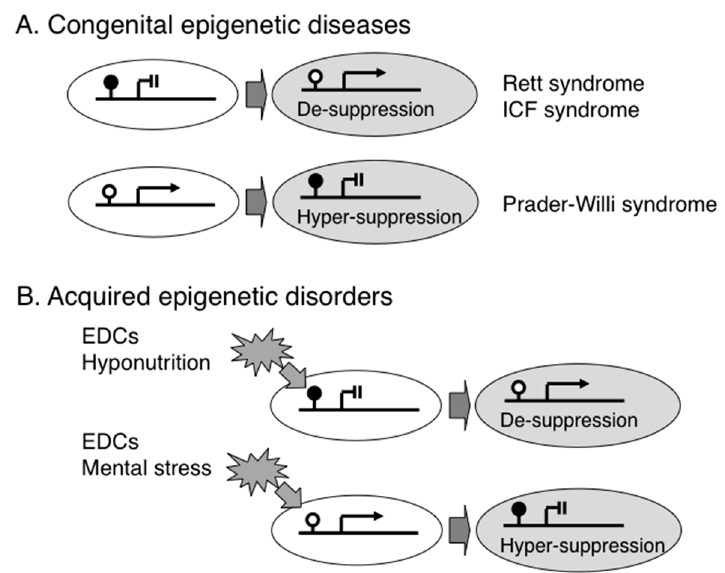
Figure 1. Epigenetic gene regulation in congenital epigenetic diseases and acquired epigenetic disorders. ( A ) Deficiency of DNA-binding protein or DNA methylation causes Rett syndrome (an ASD) or ICF syndrome (an immunodeficiency disease), respectively. Congenital aberrant DNA methylation due to genomic imprinting error causes Prader-Willi syndrome; and ( B ) Various environmental factors such as endocrine disrupting chemicals (EDCs), hyponutrition, and mental stress are known to alter epigenetic status, resulting in aberrant gene expression.